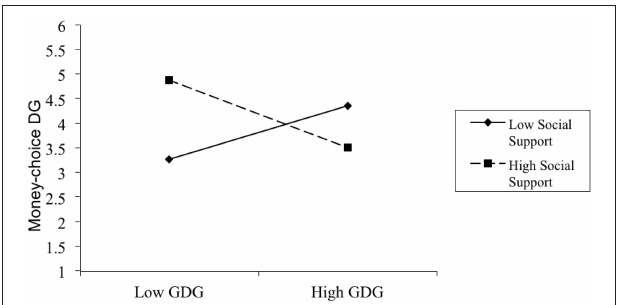
FIGURE 4 | Interaction between GDG and social support manipulation on money-choice DG. Note: low = 1 SD below the mean; high = 1 SD above the